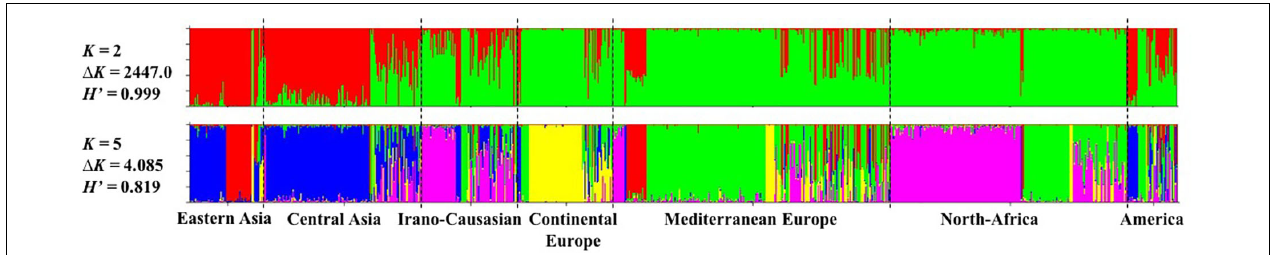
FIGURE 1 | Inference of population structure based on 25 SSR markers using STRUCTURE program for K = 2 and K = 5. Each individual is represented by a single vertical line, which is partitioned into colored segments in proportion to the estimated membership in the K clusters. The seven apricot geographic groups are separated by a black line. H’ represents the similarity coefficient between ten runs for each K, and (cid:49) K is the ad hoc measure of Evanno.